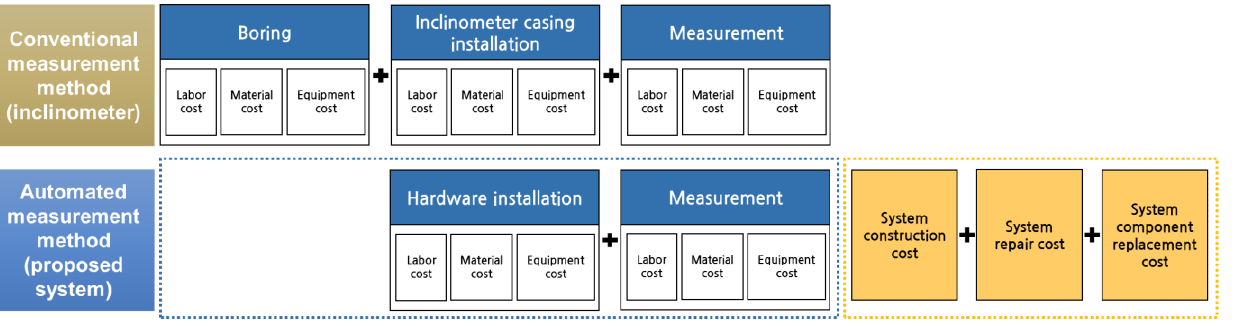
Figure 13. Life cycle cost (LCC) analysis scope.